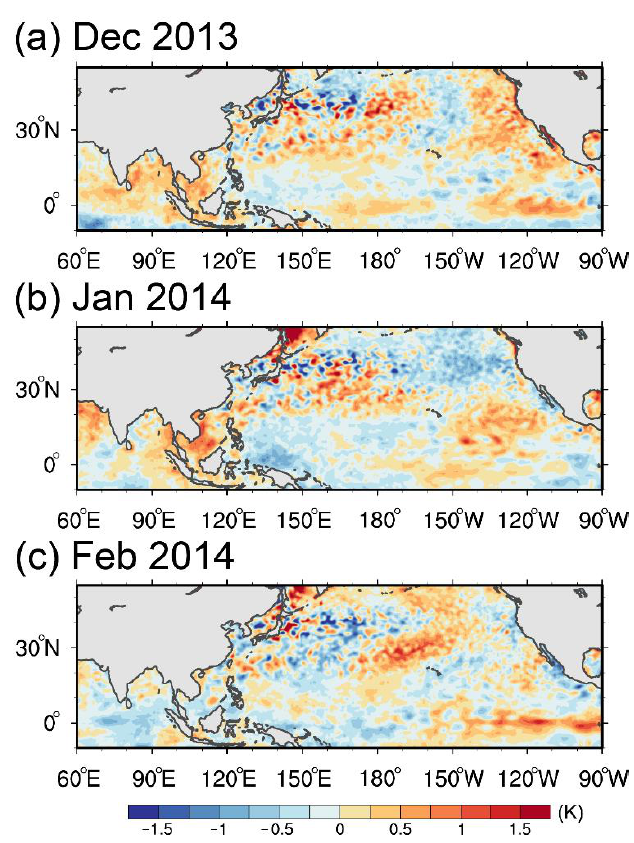
Figure 14. Composite of the SST difference between CFS forecast (also used as the lower boundary in MPAS) and CFSR in ( a ) December 2013, ( b ) January 2014, and ( c ) February 2014.